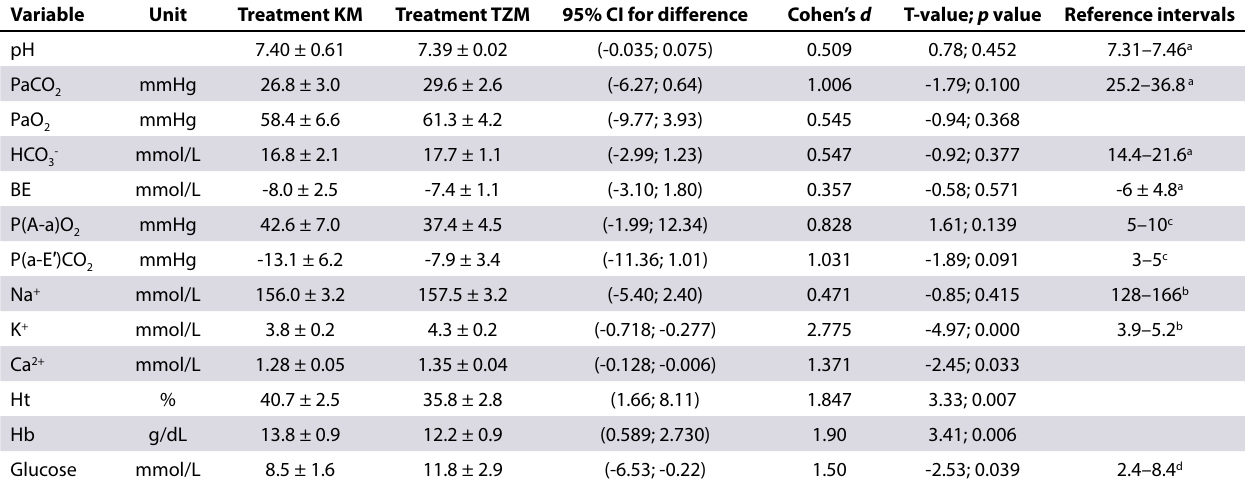
Table II: Arterial blood gas parameters of seven cheetahs ( Acinonyx jubatus ) 15 minutes after being immobilised twice, once each with